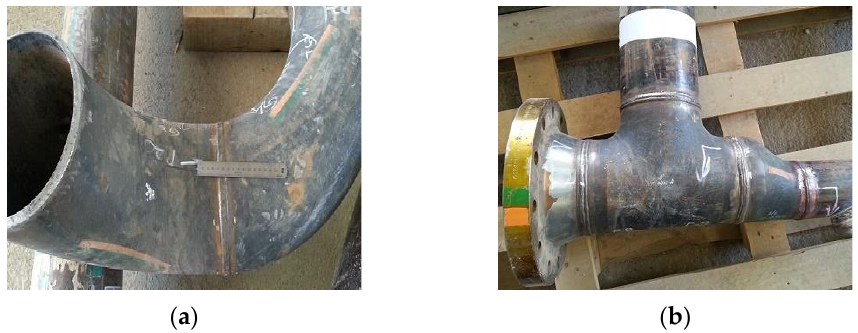
Figure 1. Piping and fitting with various curvature structures: ( a ) elbow; ( b ) flange and reducer.